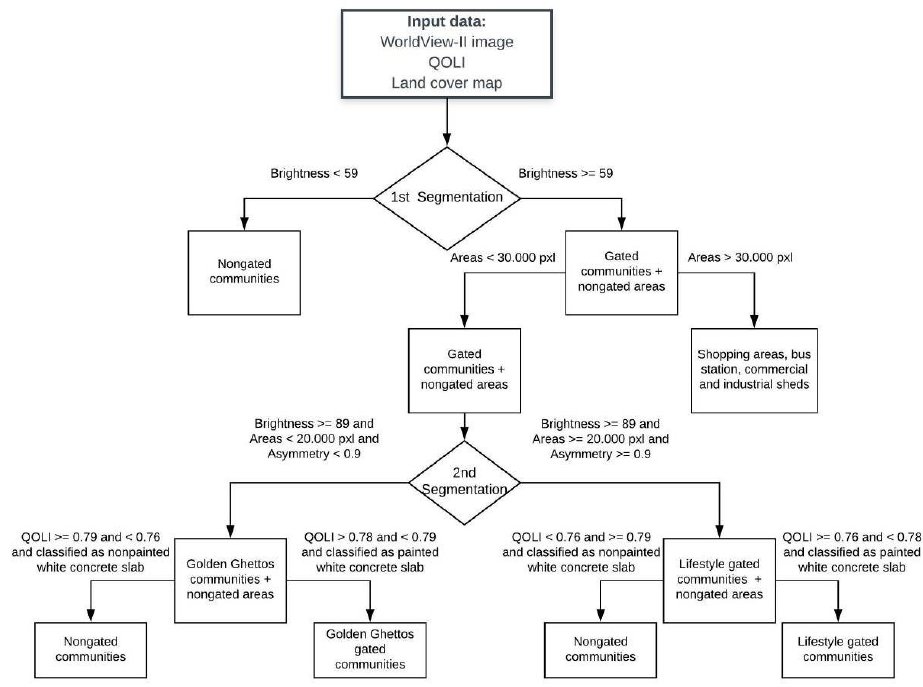
Figure 8. Classification rule decision tree to classify GC into categories.